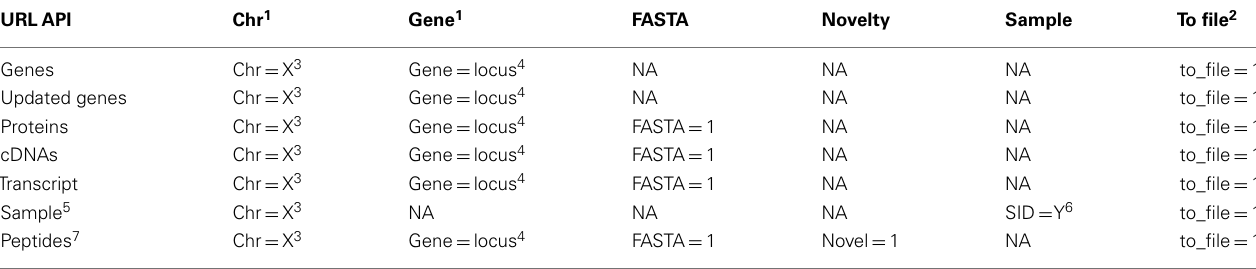
Table 1 | OryzaPG-DB